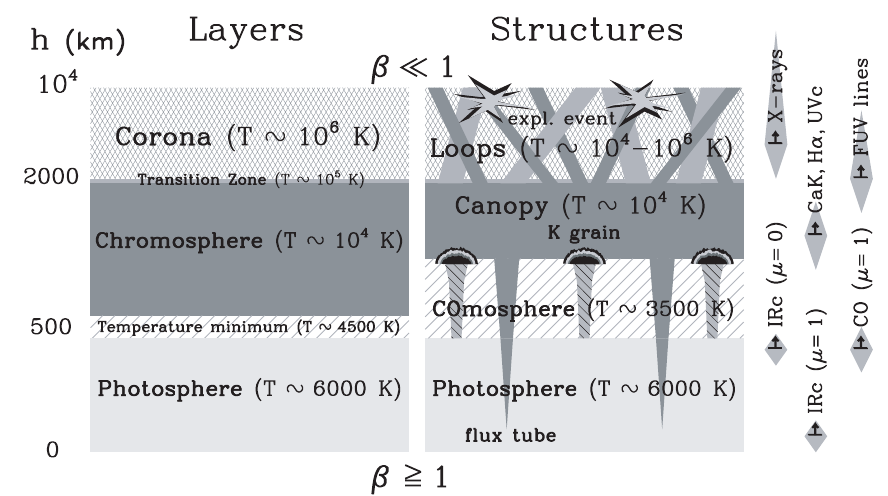
Figure 6: This figure shows the types of changes needed in the solar atmosphere models in order to bring the CO observations into agreement with other chromospheric measurements. The diagram on the left shows an early simple atmospheric model, and the diagram on the right shows the updated model after the discovery of strong CO lines and dynamic shock waves in the chromosphere. Image reproduced with permission from Ayres (2002), copyright by